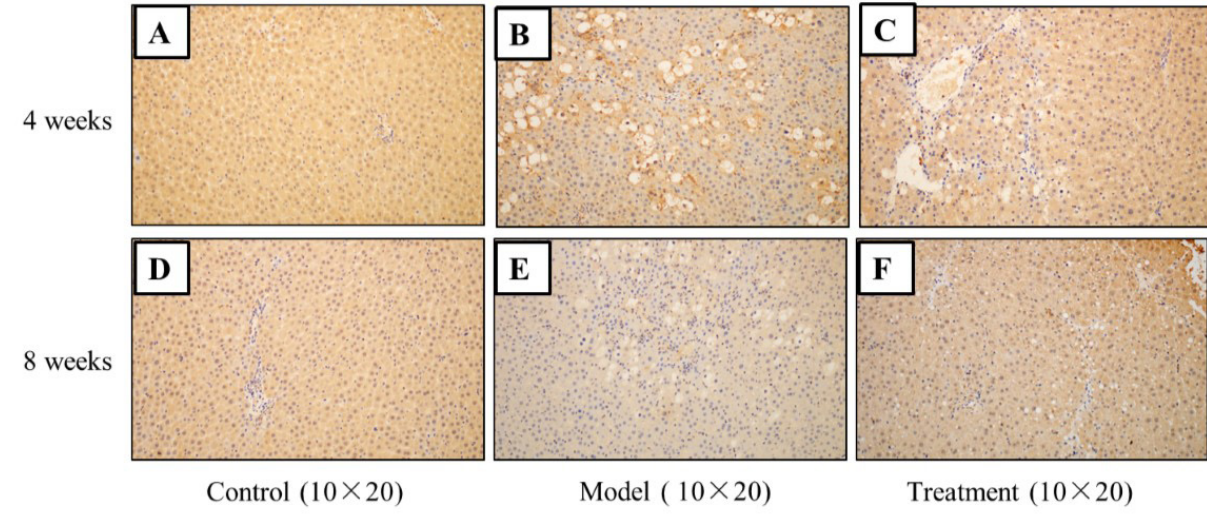
-induced group, and DHZCP-treated group at 4